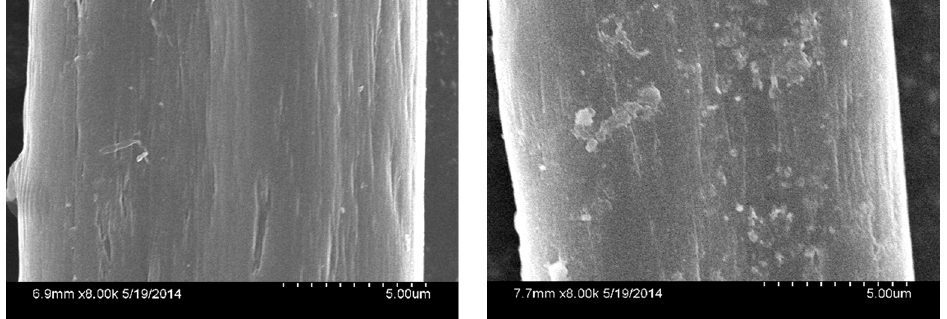
Figure 2. SEM image of unfunctionalized and TNP-functionalized polyester-cotton (65/35) silk.